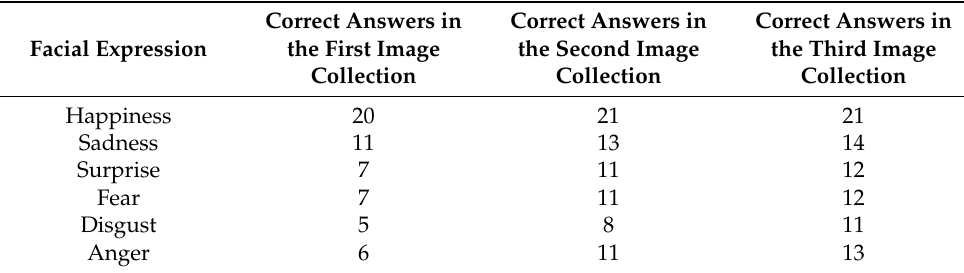
Table 8. The caregiver reports on child interaction with the facial expression of the three face collections with correct answers (0#x2013;30) for ASD children in the two days.